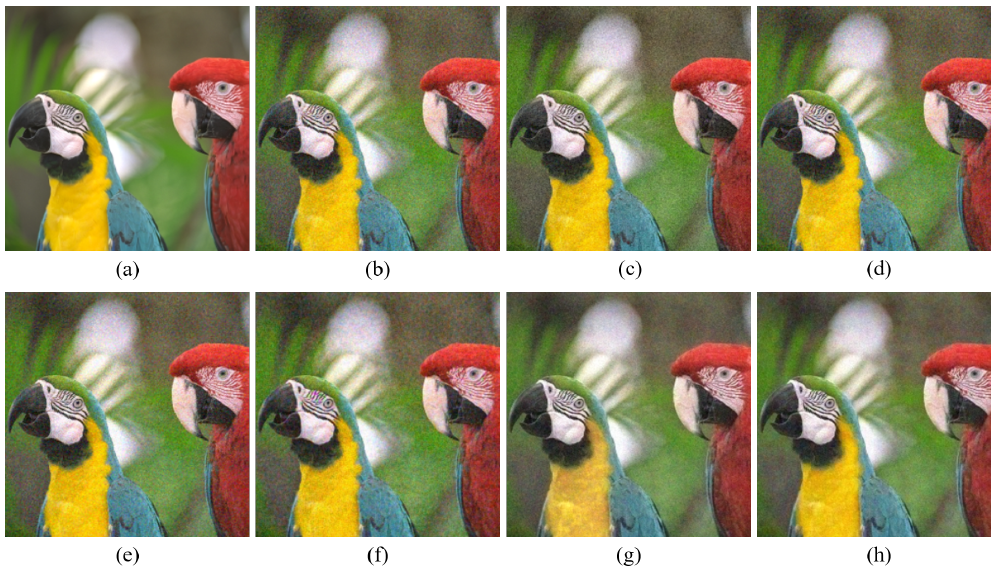
Figure 16. Demosaicing results of the Kodak No. 23 image under high-noise condition. ( a ) Original